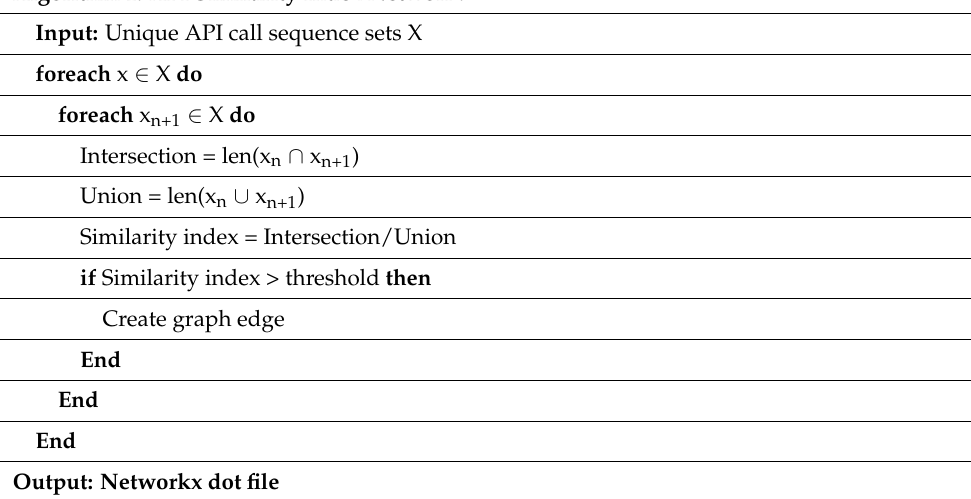
Algorithm 1: API Similarity Index